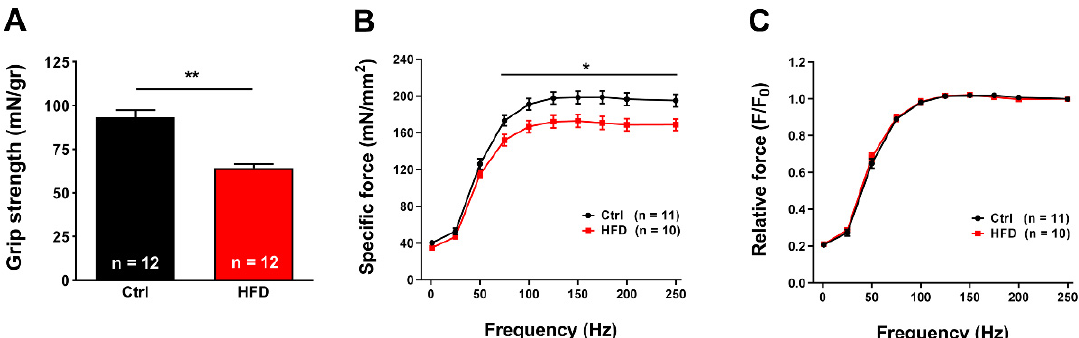
Figure 3. Grip strength and in-vitro specific force. ( A ) Grip strength normalized to body weight (in mN/gr). ( B , C ) Force frequency (1–250 Hz) curve of specific (panel ( B )) and relative force normalized to 250 Hz (panel ( C )) in isolated EDL muscles. Data are shown as mean ± SEM (* p < 0.05 and ** p < 0.01), as evaluated by two-way ANOVA followed by Tukey’s post-hoc test (panel ( B )) or two-tailed unpaired Student’s t -test (panel A ). n = number of mice tested (in panel ( A )). n = number of EDL muscles tested (in panels ( B ) and ( C )).